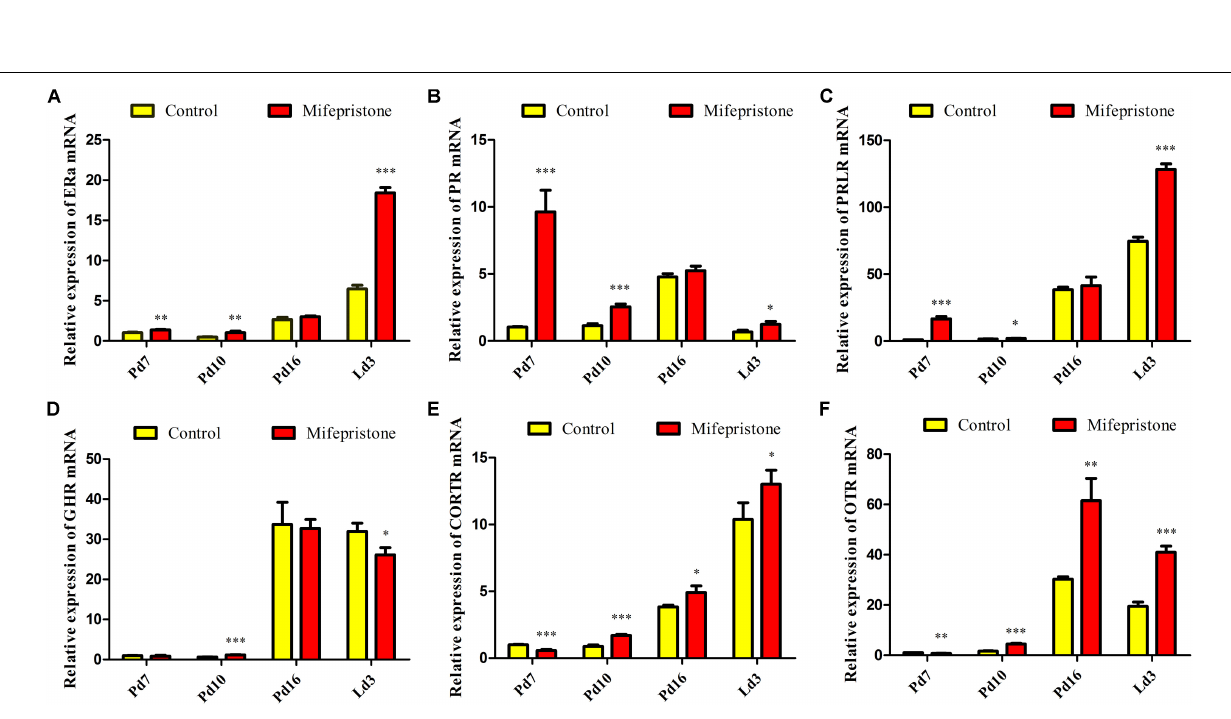
Frontiers in Cell and Developmental Biology |